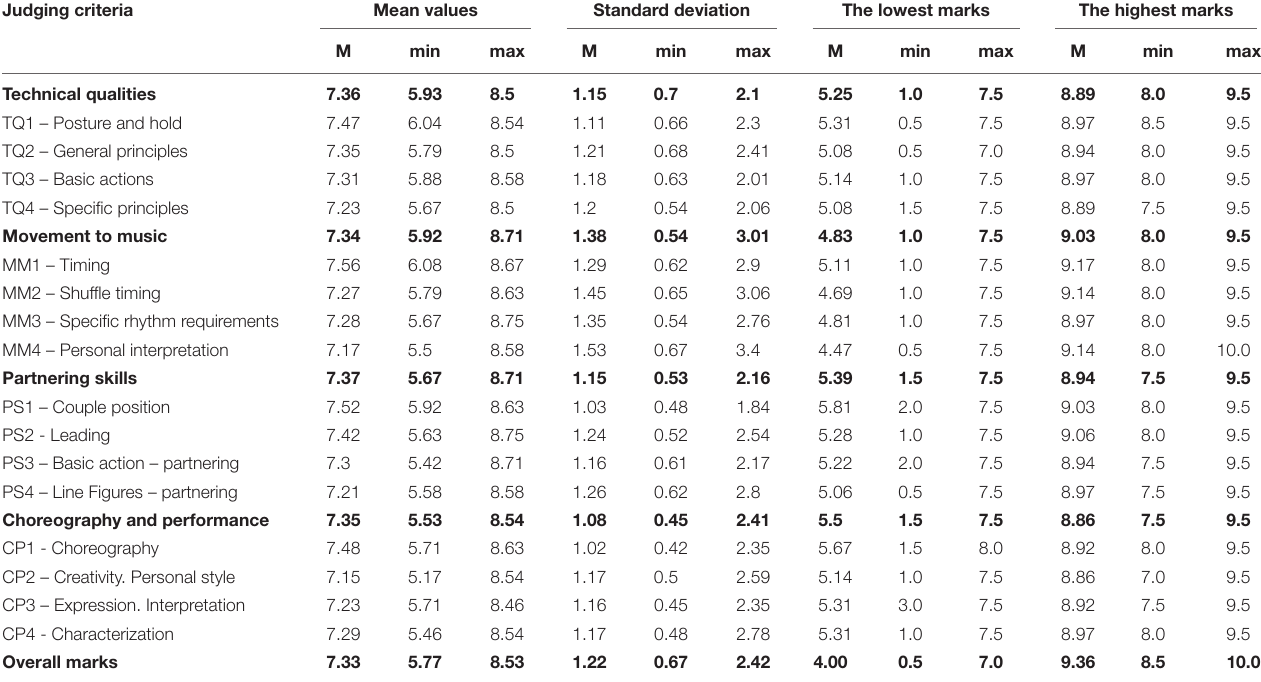
TABLE 2 | Mean, average, minimum and maximum values for judging criteria. Judging criteria Mean values Standard deviation The lowest marks